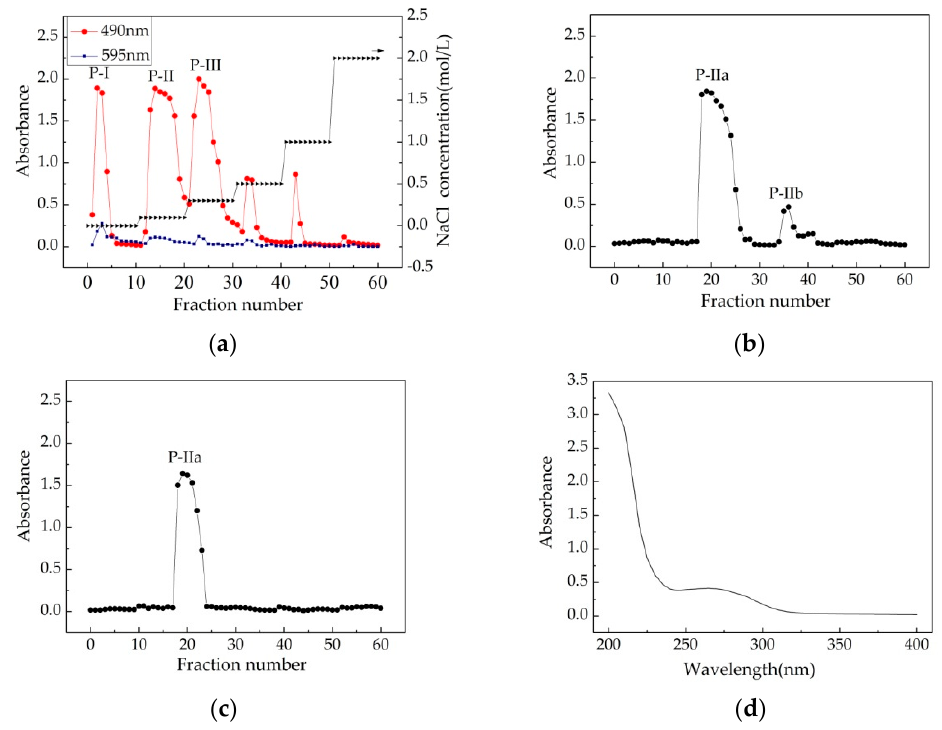
Figure 3. Isolation and physicochemical analysis of the polysaccharides extracted from Chlorella -Arc. ( a ) DEAE-Sepharose Fast Flow chromatogram elution curve of Chlorella -Arc polysaccharides. Fractions were collected and examined for metachromasia using phenol-H 2 SO 4 ( ) and Coomassie brilliant blue ( ). There were three major fractions in the crude Chlorella -Arc polysaccharide (P-I, P-II, and P-III). ( b ) Sephadex G-100 chromatogram elution profile of P-II; ( c ) Sephadex G-100 chromatogram elution profile of P-IIa; ( d ) UV-Vis spectrum of P-IIa.